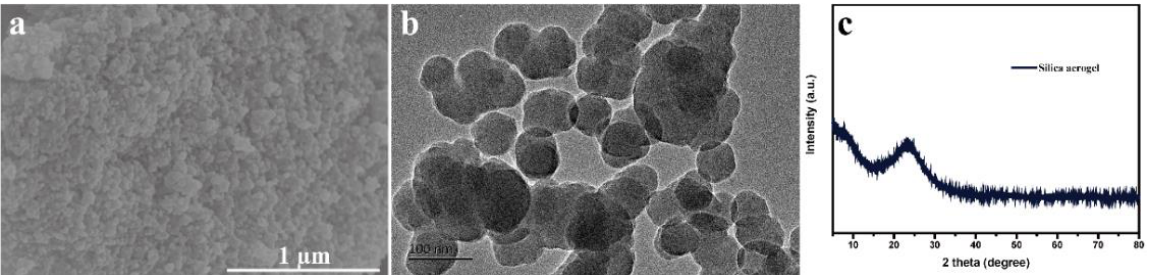
Figure 1. SEM ( a ), TEM ( b ) image, and XRD ( c ) pattern of silica aerogel.